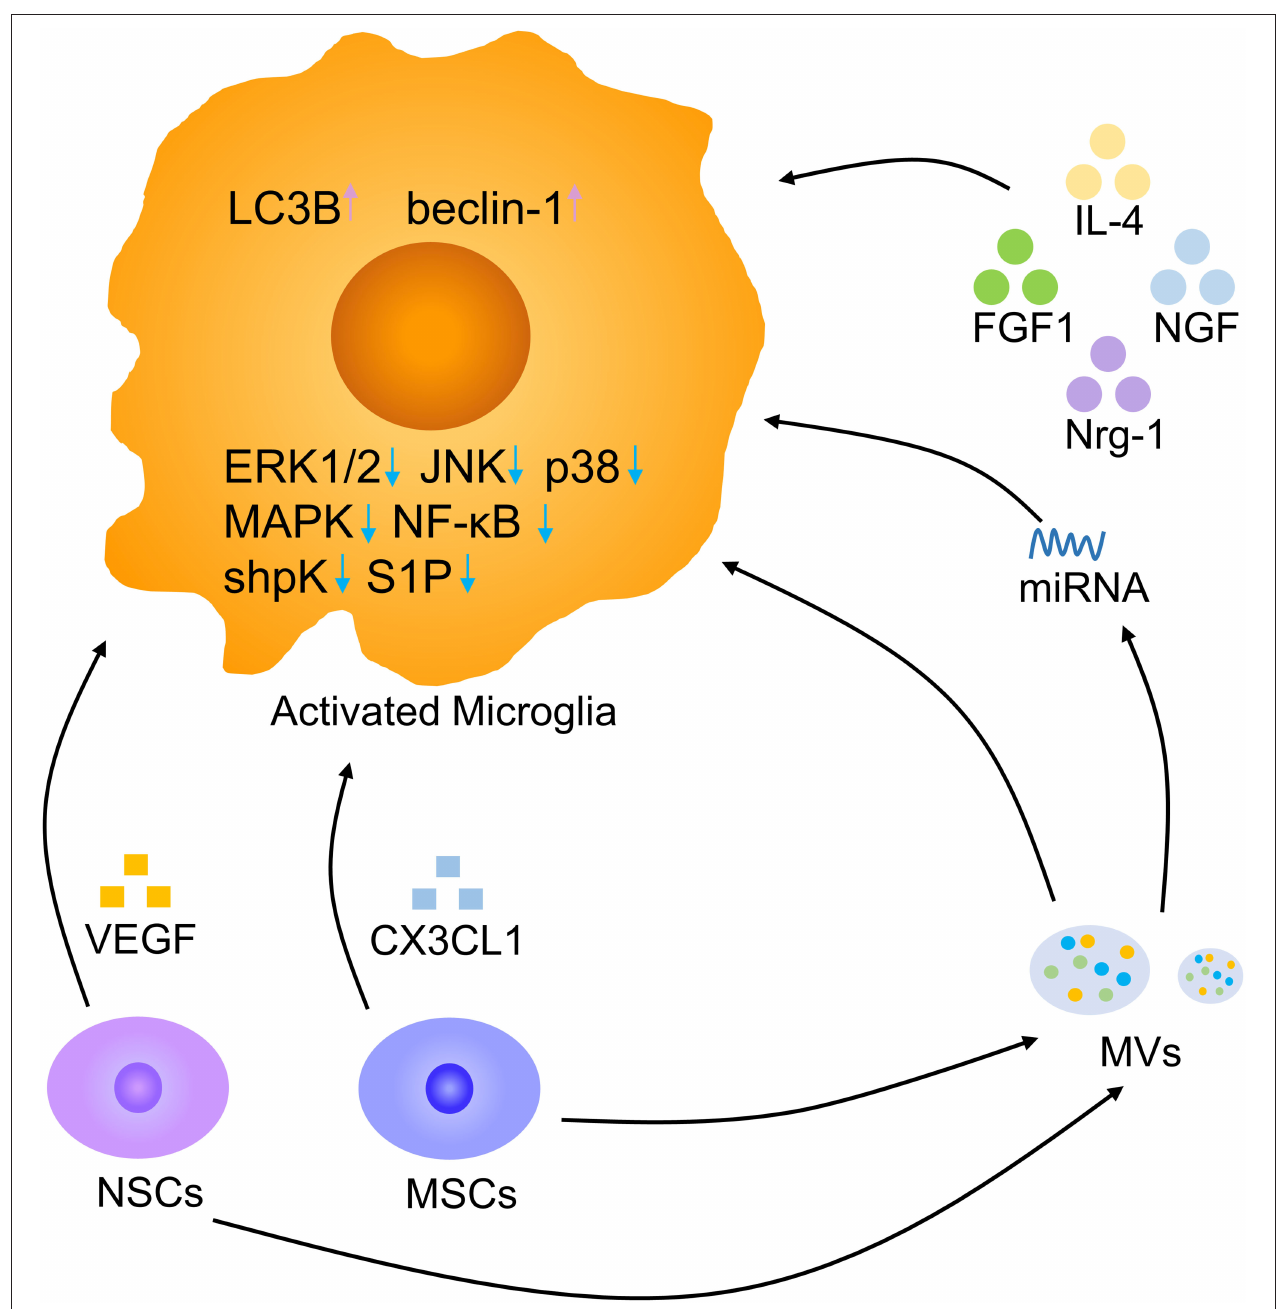
FIGURE 8 | Microglia modulation by biotherapy. Multiple cytokines, NSCs, MSCs, and MVs derived from stem cells, and miRNAs derived from MVs contribute to a decrease in activated microglia. Pink arrow, upregulation; blue arrow,